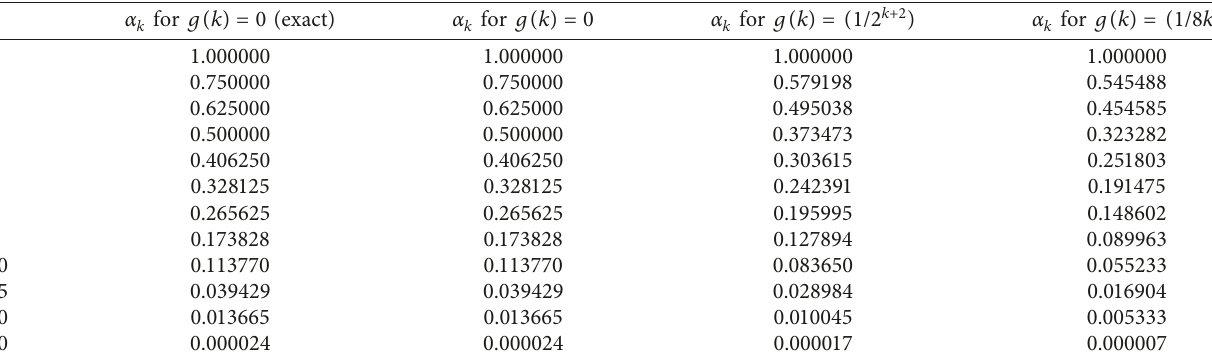
Table 2: Numerical computation of the absorption probabilities by means of the GCF-based approach. k α k for g ( k ) � 0